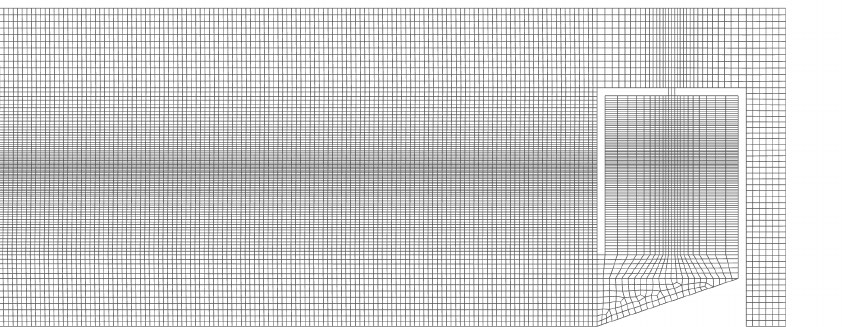
Figure 2. Mesh generation of the OWC